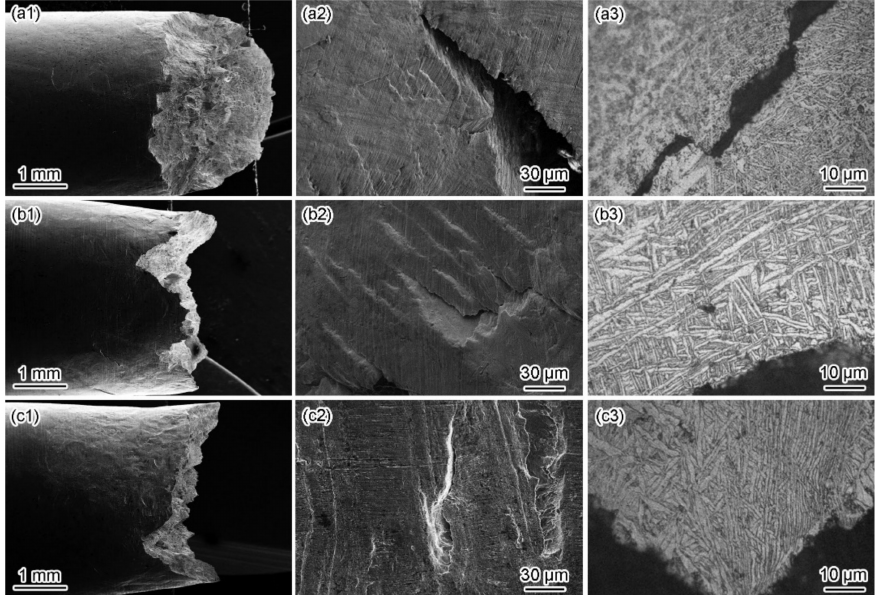
Figure 8. Fracture side morphologies in a simulated deep − sea environment. Macromorphology of fracture side at − 1.3 V ( a1 ), E corr ( b1 ), and 1.5 V ( c1 ); micromorphology of secondary crack at − 1.3 V ( a2 ), E corr ( b2 ), and 1.5 V ( c2 ); metallography of main crack at − 1.3 V ( a3 ), E corr ( b3 ), and 1.5 V ( c3